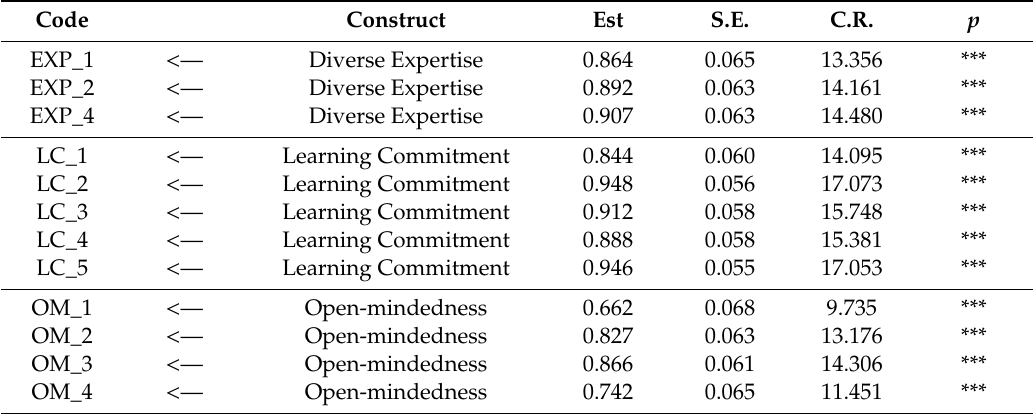
Table 3. CFA Measurement Model